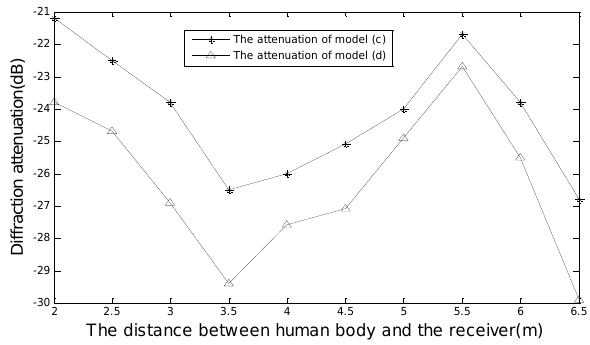
Figure 8. Attenuation measurements of model (c) and model (d).